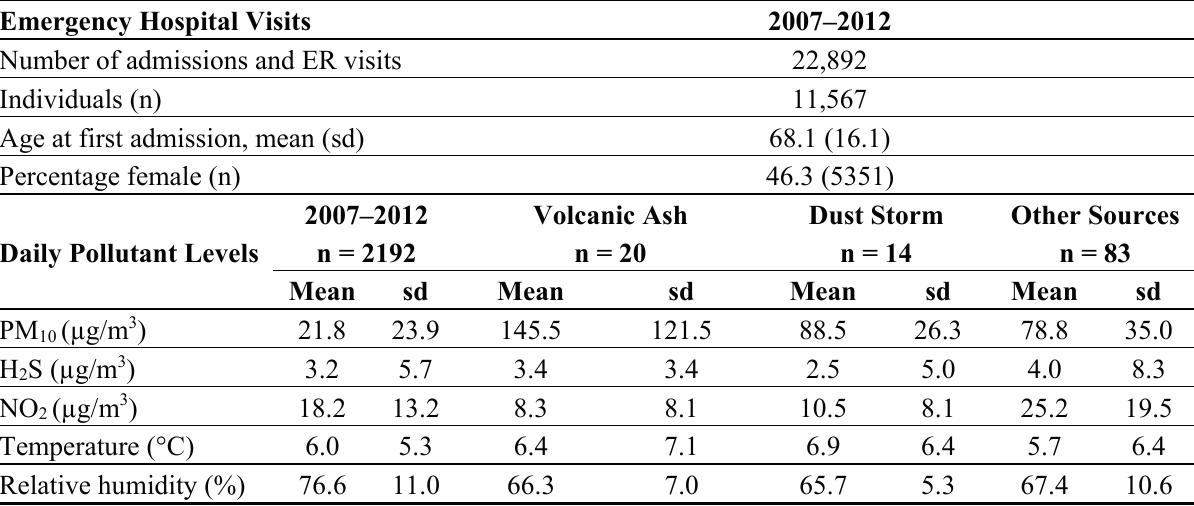
Figure 1. Daily (24-h) averages values of PM 10 and its sources during exceedance of the air quality guideline value of 50 µg/m 3 (dotted line). Table 1. Descriptive statistics of the data and daily emergency hospital visits and daily pollutants during the study period and stratified by time-strata used in the